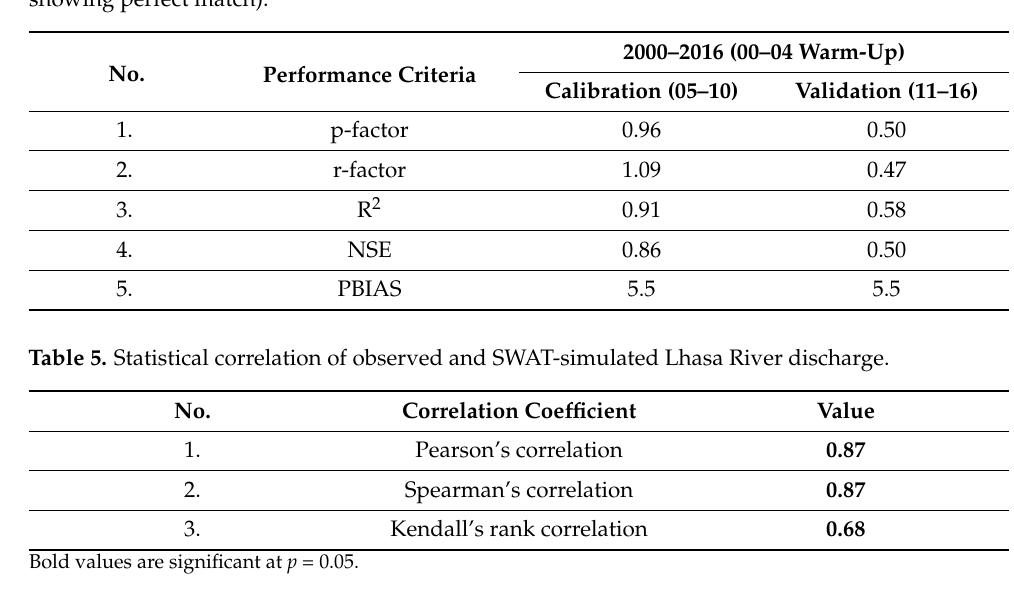
Table 4. Performance of the SWAT model in simulation of Lhasa River flow under reservoir opera- tions. p-factor: percentage of data that is enclosed by the 95PPU band; r-factor: the average width of the 95PPU band divided by the standard deviation of the measured variable (from 0 to ∞ , with 0 showing perfect match).